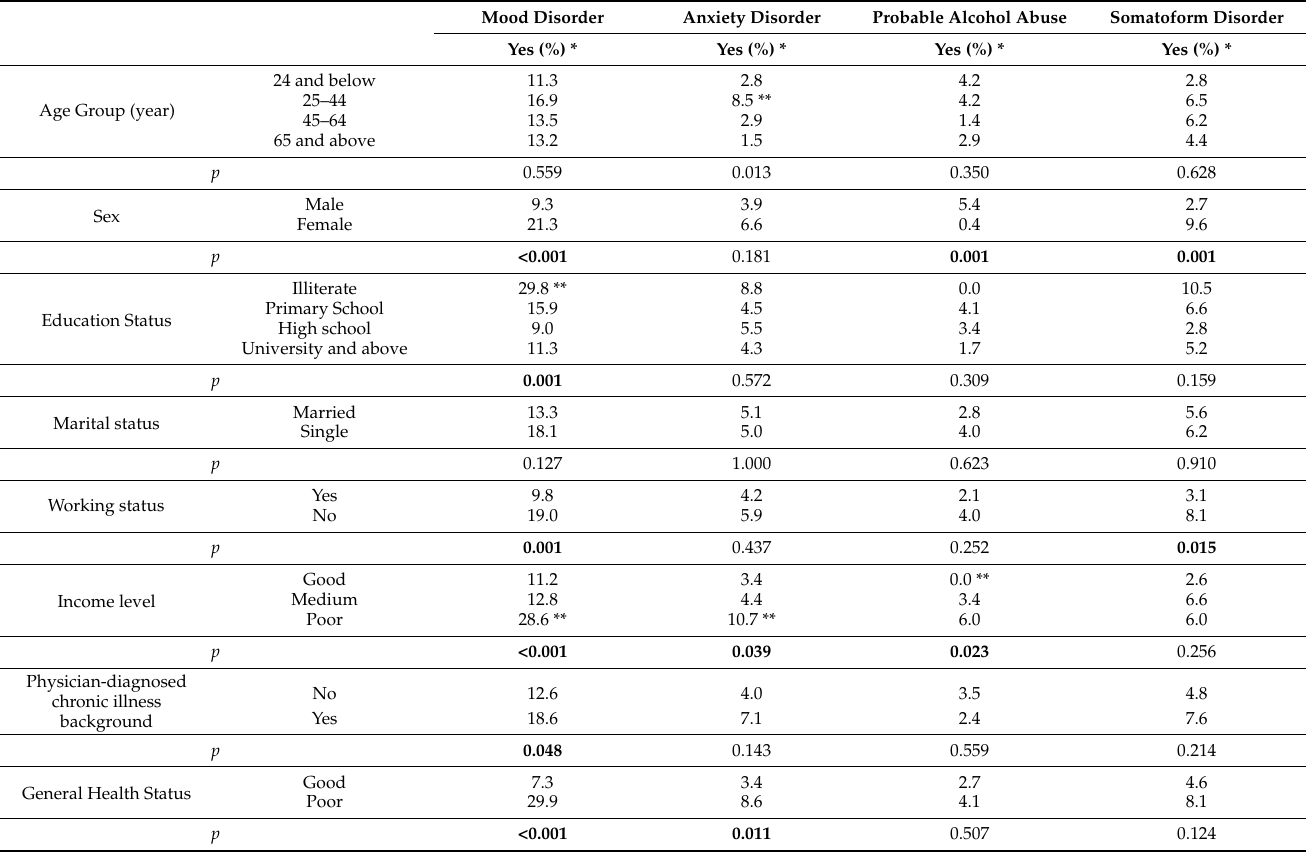
Table 1. The distribution of mental disorder diagnoses obtained from PRIME MD modules according to the socio-demographic characteristics in the study group.